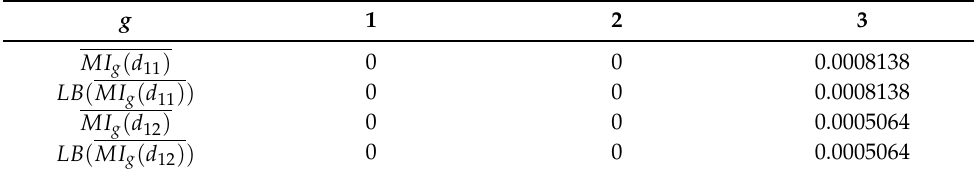
Table 6. Numerical results of Example